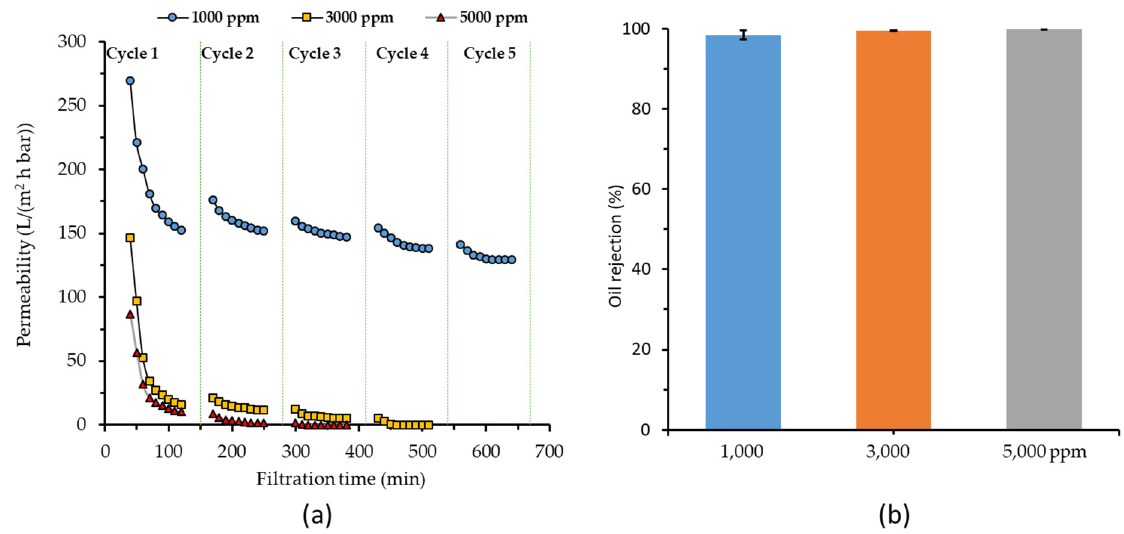
Figure 5. Effect of feed oil concentration on ( a ) hydraulic performance and ( b ) oil rejection for filtration of 1000 ppm oil/water emulsion feed using PSF/PEG-60 membrane evaluated at a constant transmembrane pressure of 0.2 bar.